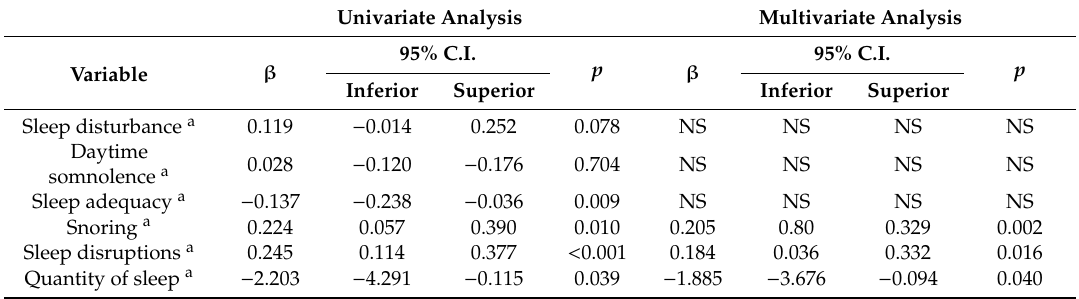
Table 4. Univariate and multivariate linear regression to analyze the factors related to migraine-related disability. Univariate Analysis Multivariate